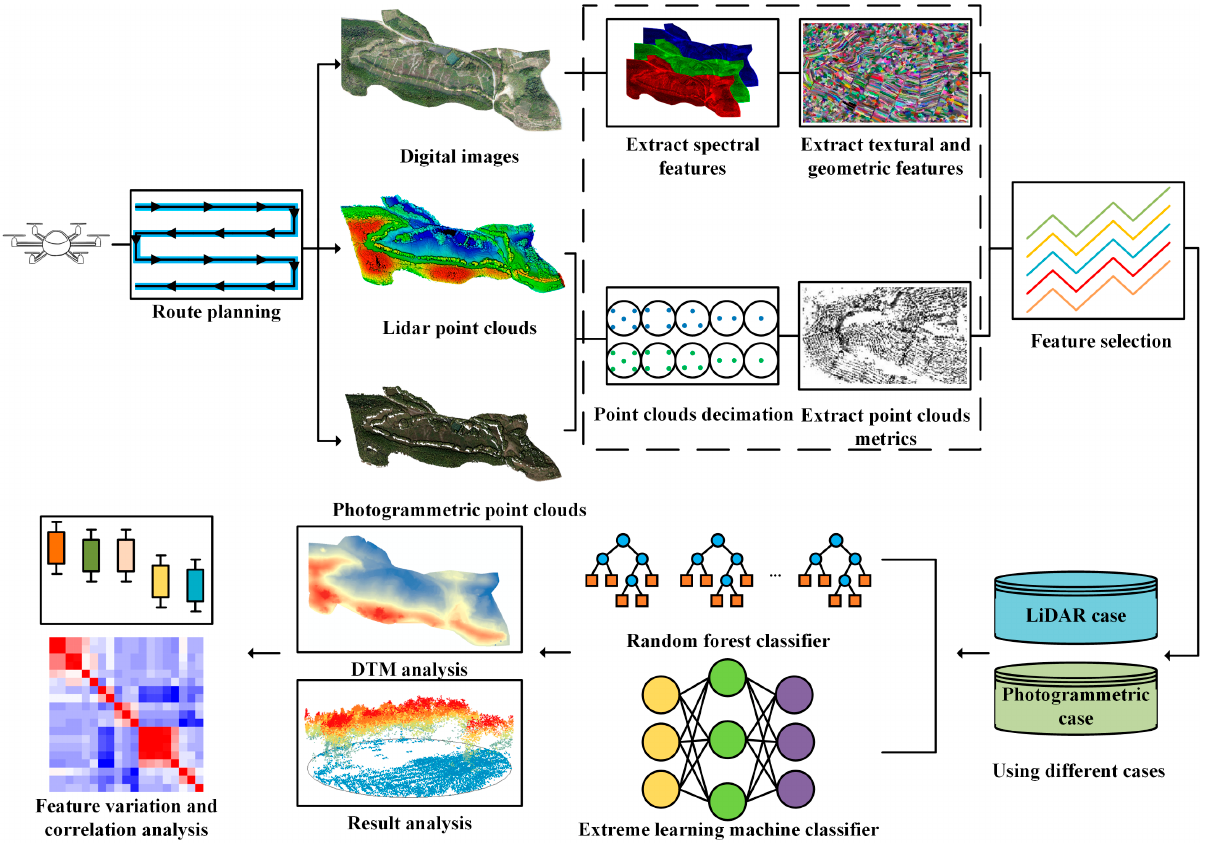
Figure 4. A schematic graph of the point cloud performance comparison with LiDAR and photogrammetric cases.